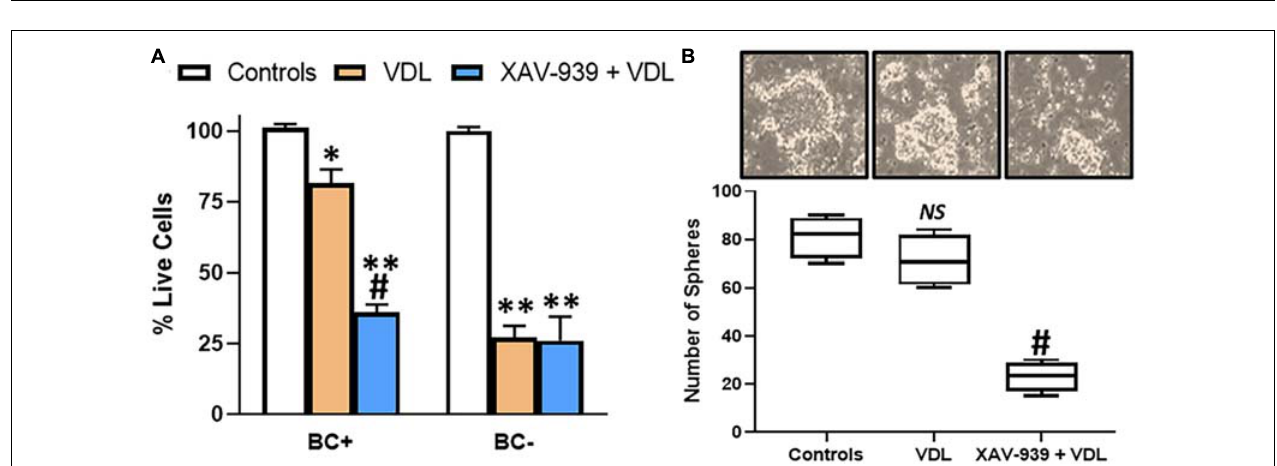
FIGURE 2 | β -catenin confers drug resistance and 3-dimensional cell growth. (A) Flow sorted β -catenin-positive (BC+) and β -catenin-negative (BC–) cells were subjected to VDL treatment, as described in section “Materials and Methods,” in the presence and absence of 5 µ M XAV-939 for 10 days. Live cells were estimated by trypan blue exclusion method. (B) Flow sorted β -catenin-positive cells were also allowed to grow in 3-dimensional cultures to generate tumorospheres, in the presence of VDL ± 5 µ M XAV-939. Representative images of tumorospheres are provided along with the bars representing the number of tumorospheres. ∗ p < 0.05 and ∗∗ p < 0.01, compared to control, NS , non-significant, compared to control, # p < 0.01, compared to VDL.